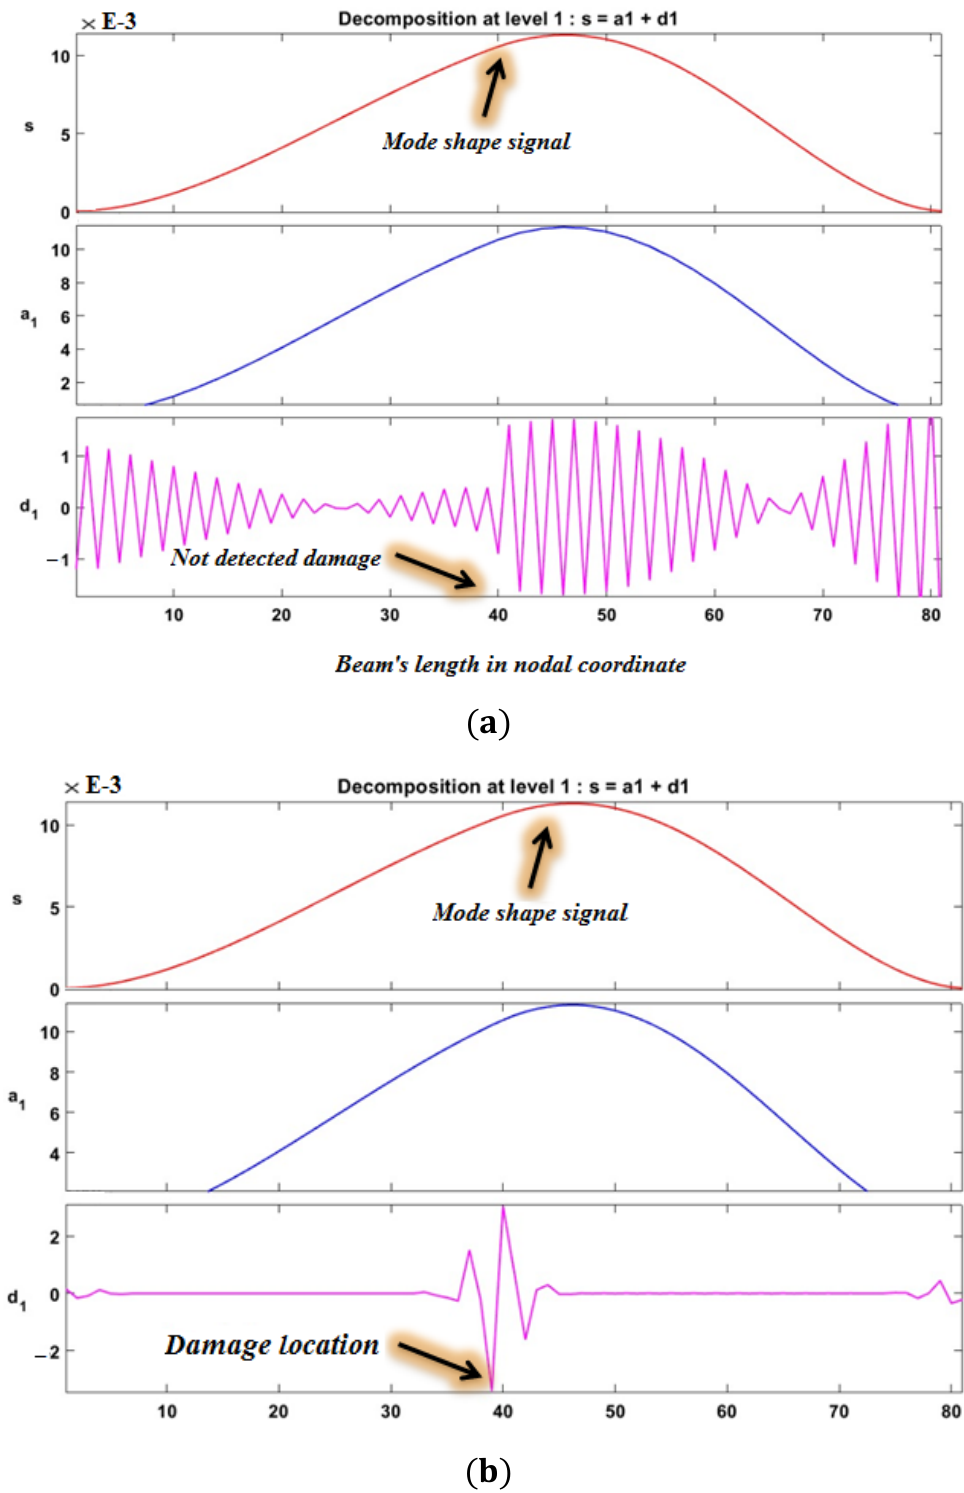
Figure 9. The effect of increasing the vanishing moments on the accuracy of damage detection by 1D-DWT from the damaged mode shape by 70% damage: ( a ) vanishing moments = 2, ( b ) vanishing moments = 5.